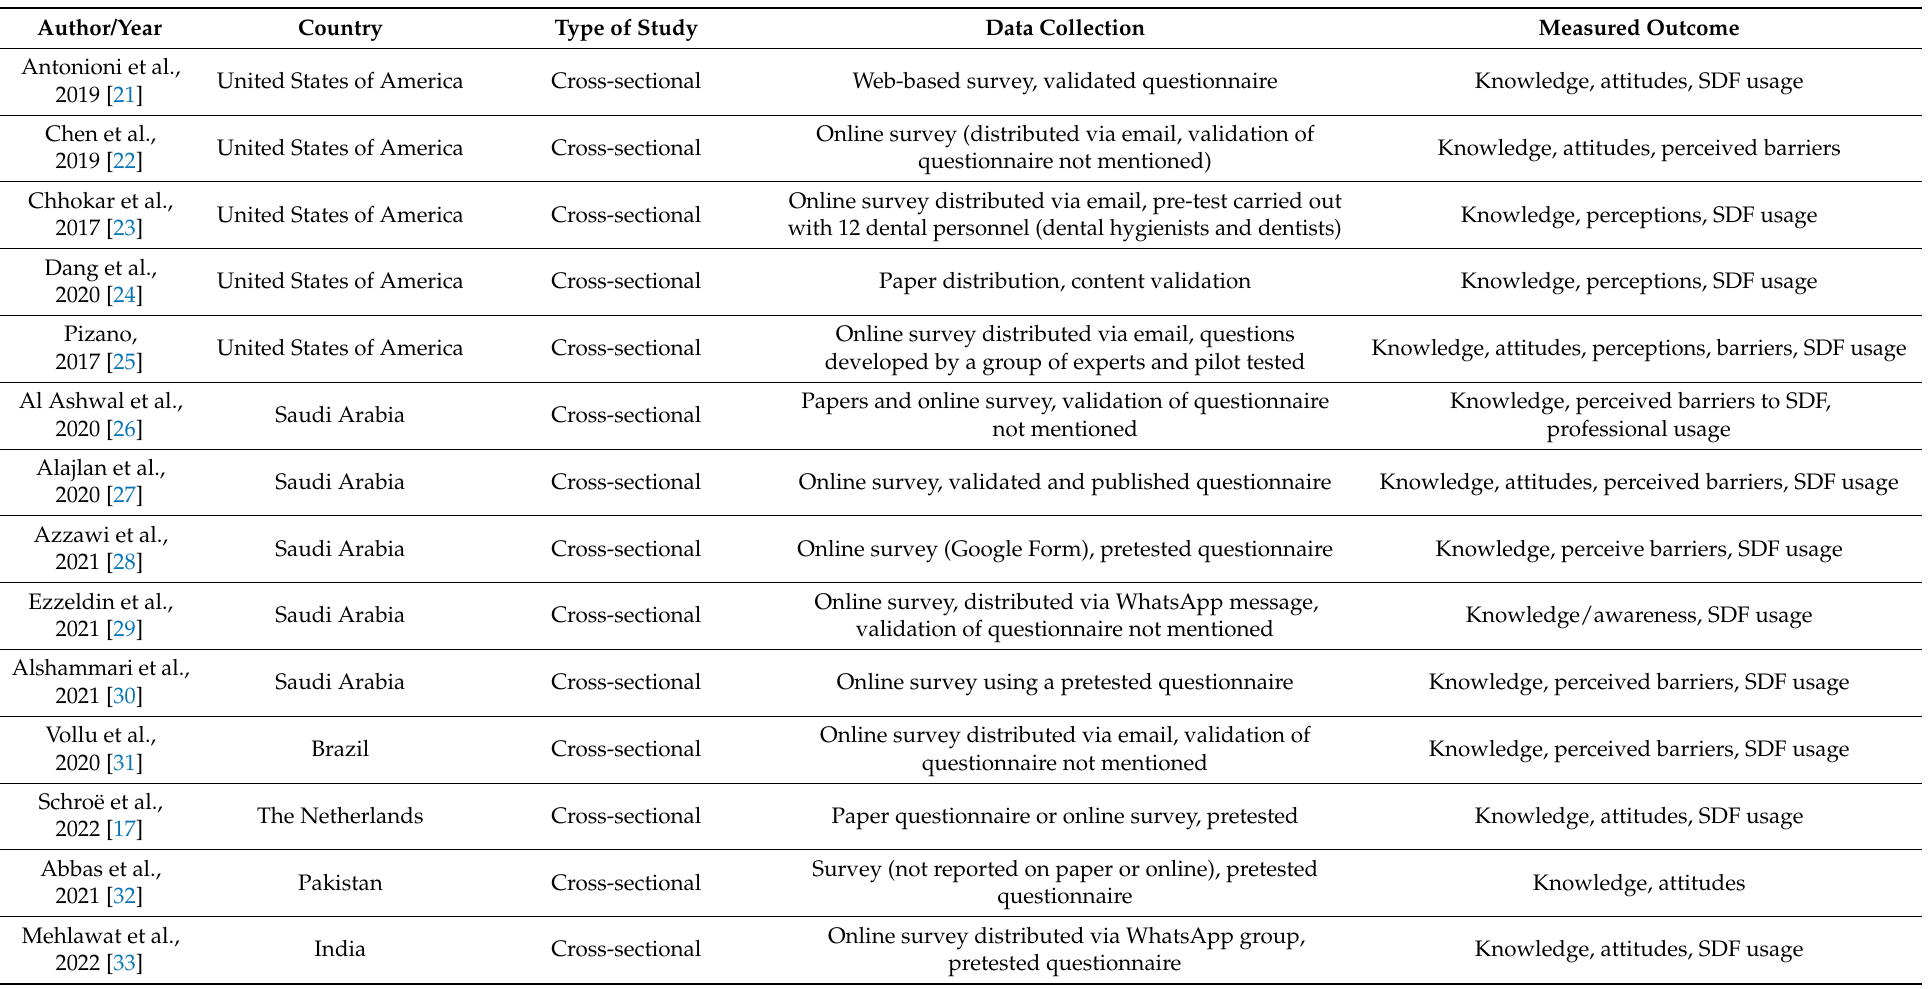
Table 1. Overview of general characteristic of studies included in the systematic